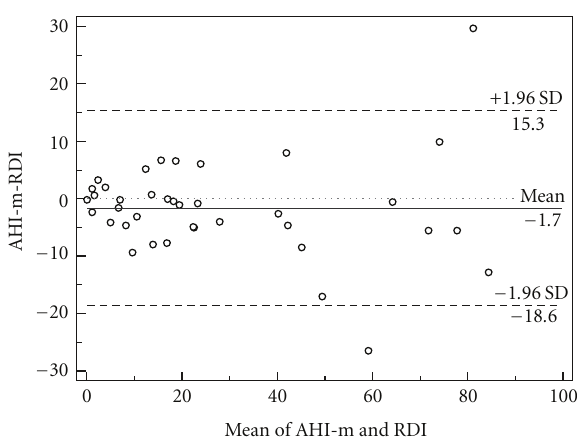
Figure 2: Bland-Altman plot of manual ApneaLink apnea/hypop- nea index (AHI-m) and the respiratory disturbance index (RDI) from